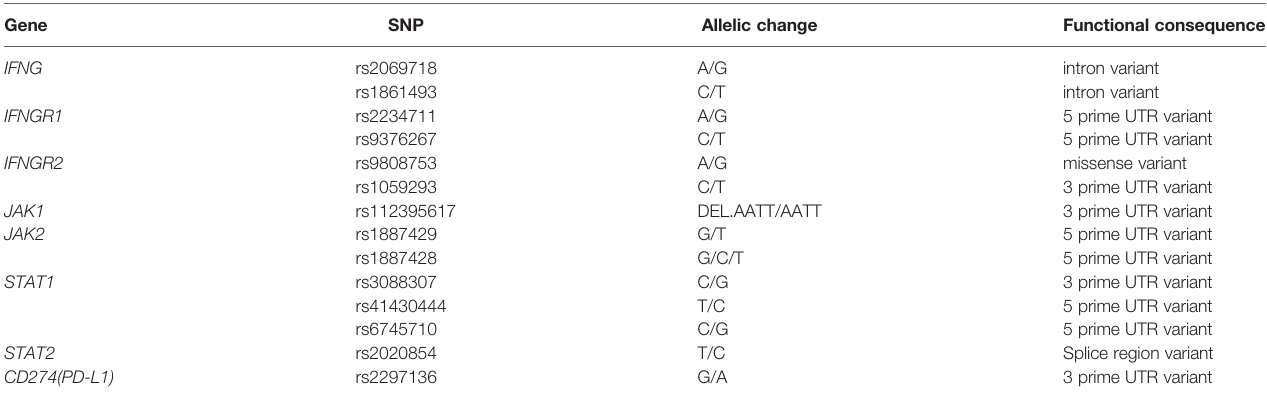
TABLE 1 | Genes and SNPs selected for analysis.